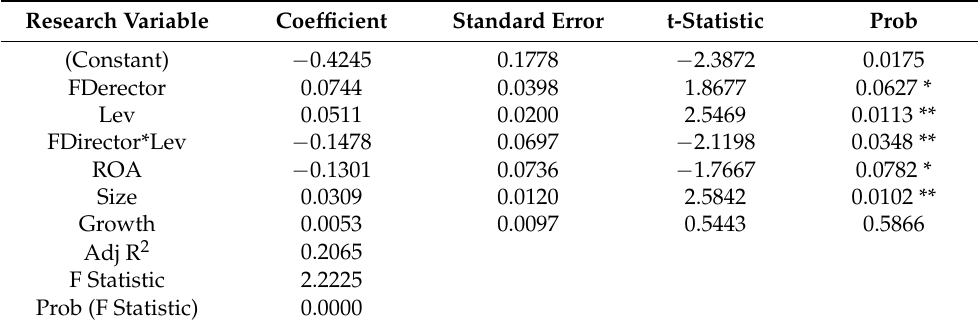
Table 4. Family Directors and Earnings